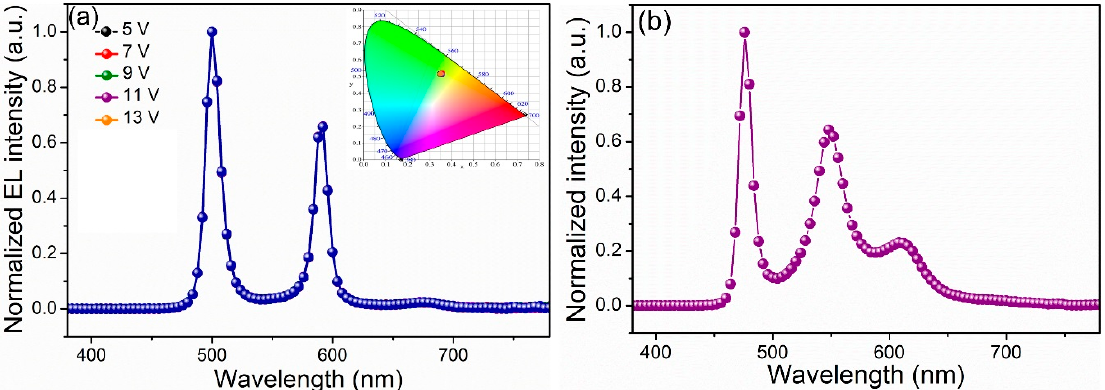
Figure 7. ( a ) EL spectrum of device A (inset is the corresponding CIE chromaticity coordinate). ( b ) EL spectrum of Device B.